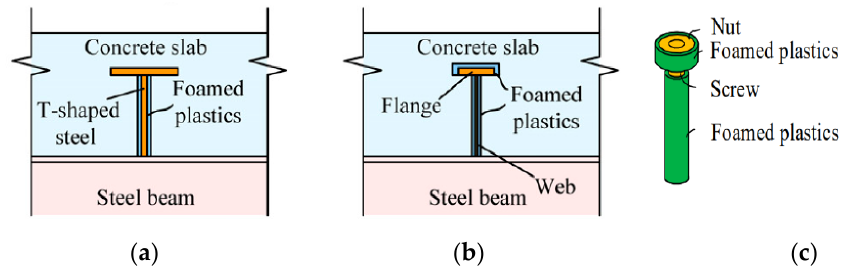
Figure 1. Common shear connectors used in steel–concrete composite bridge. ( a ) FS connector, ( b ) URSP-T connector, ( c ) URSP-S connector. ( b ) URSP-T connector, ( c ) URSP-S